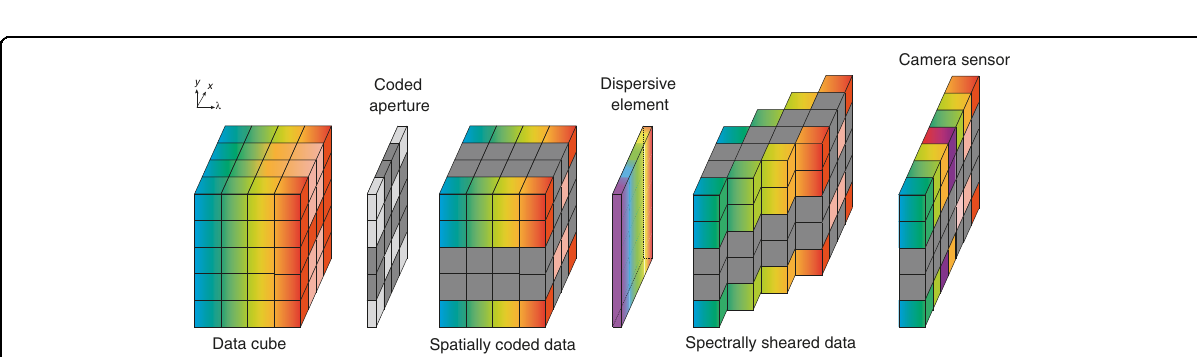
Fig. 3 Spectral imaging process within SD-CASSI architecture. The spectral data cube fi rst passes a coded aperture for spatial encoding, then its spectral arrangement is shifted by a dispersive element. Finally, a detector captures the spatial and spectral encoded data